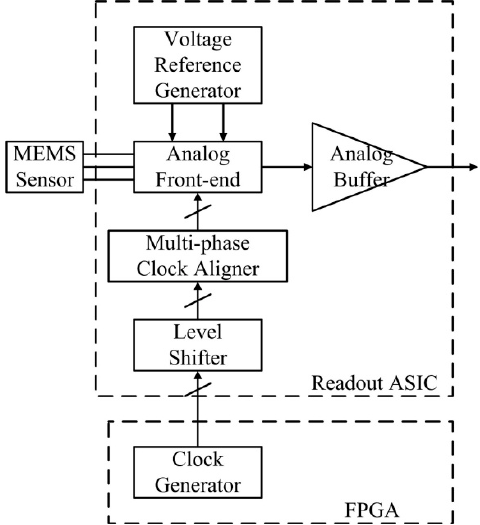
Figure 1. Structure of the open-loop accelerometer with the proposed readout ASIC.